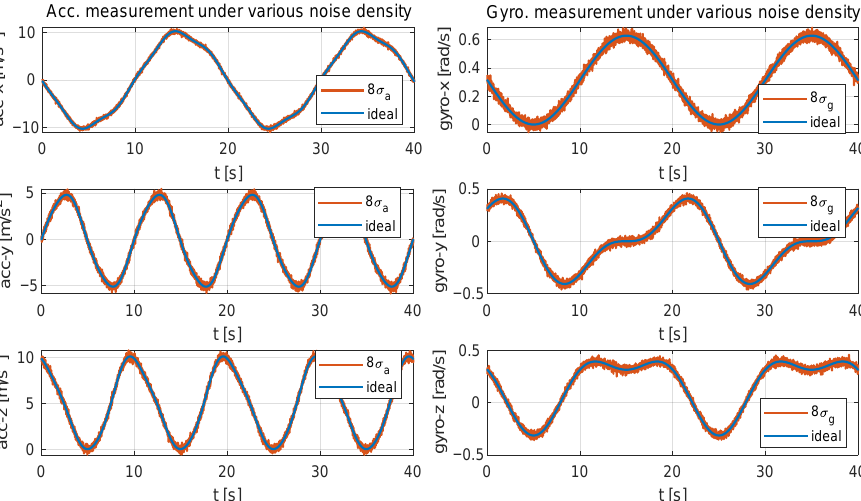
Figure 5. Two examples of the comparison between the noise-free and the noise-affected IMU mea- surements. The noise-free measurements are generated by computing the analytical derivatives of the parametric trajectory shown in Figure 4. The left subplots compare the noise-free accelerometer mea- surements with the noise-affected ones. The noise-affected measurements are generated by adding Zero-mean Gaussian noises with densities of 8 σ a to the three axes of the noise-free accelerometer measurements. The right subplots show a similar comparison for gyroscope